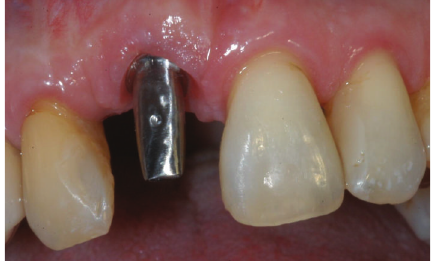
Figure 19: Three months after the placement of provisional restora-